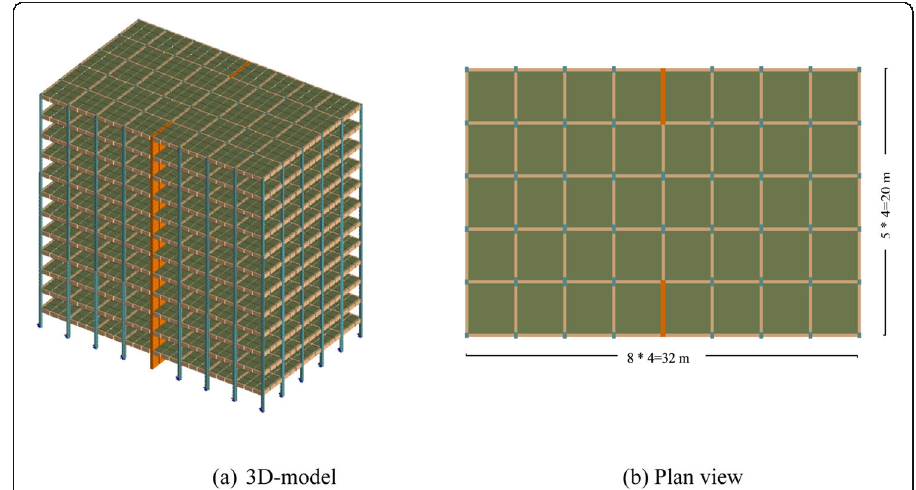
Fig. 8 General layout of the references building model (color should be used for this figure). a